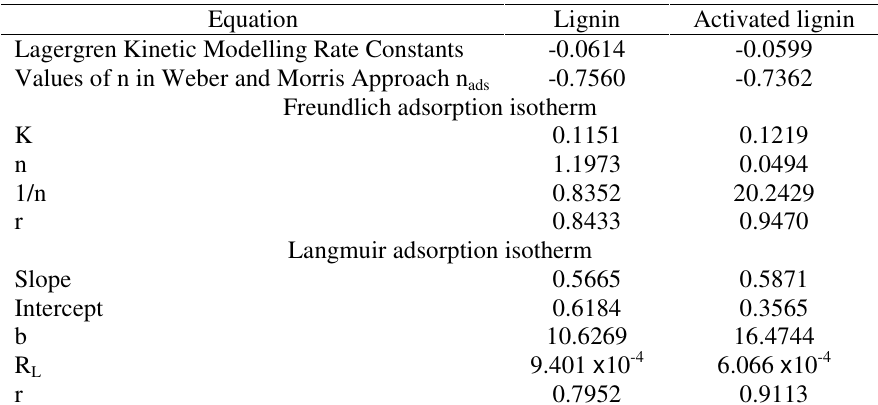
Table 7. Interpretation of data in terms of